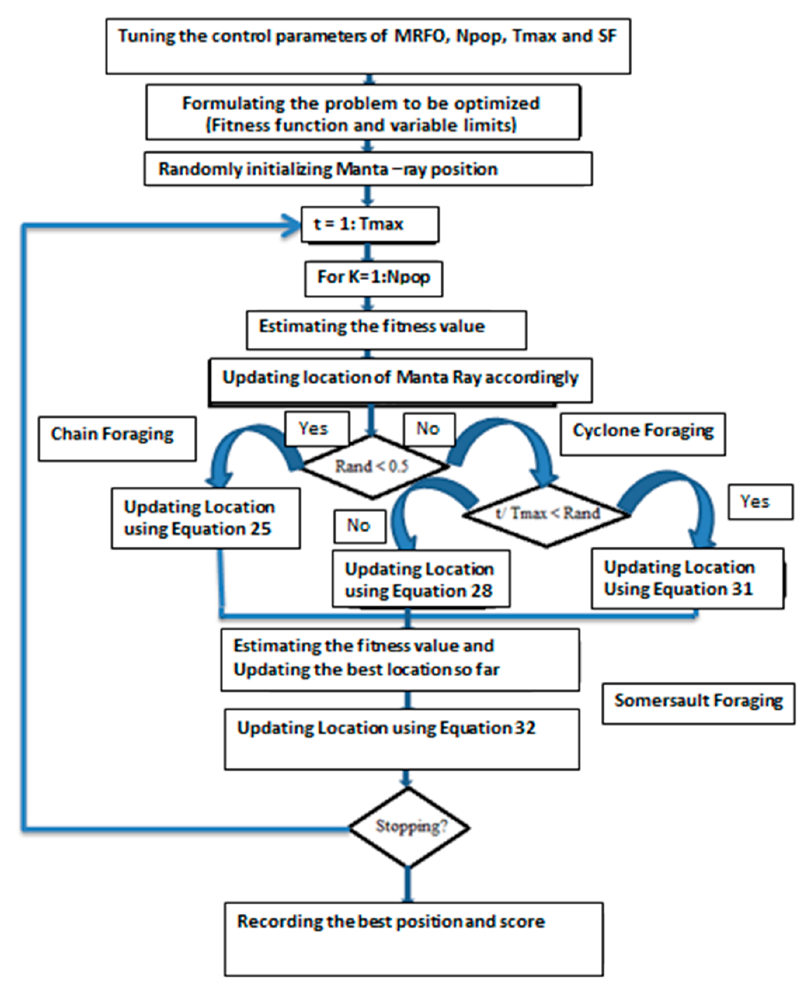
Figure 7. Manta Ray Foraging Optimization (MRFO) flow chart.